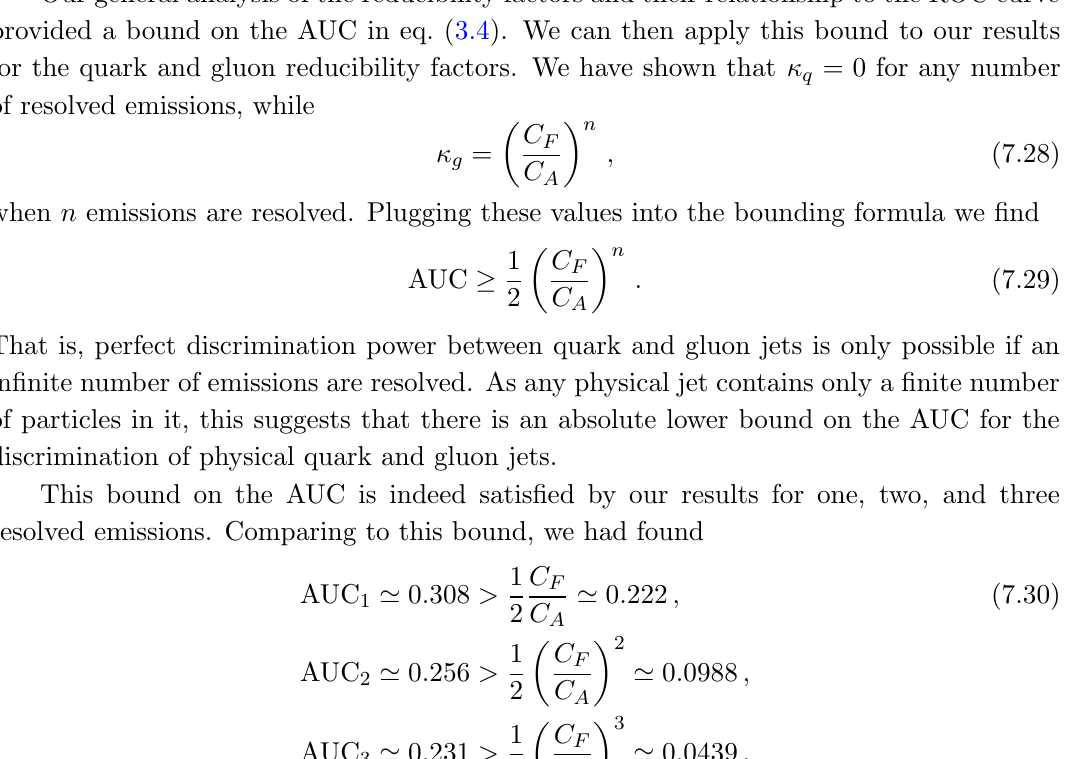
0 : 3 and (cid:13) = 0 : 1 where it takes the value 0 : (cid:0)